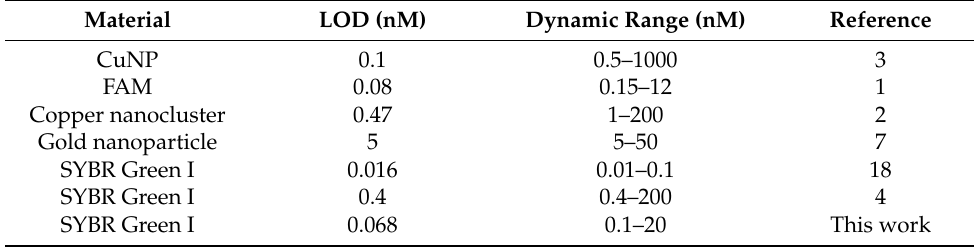
Table 1. Comparison of different methods for the detection of SA.